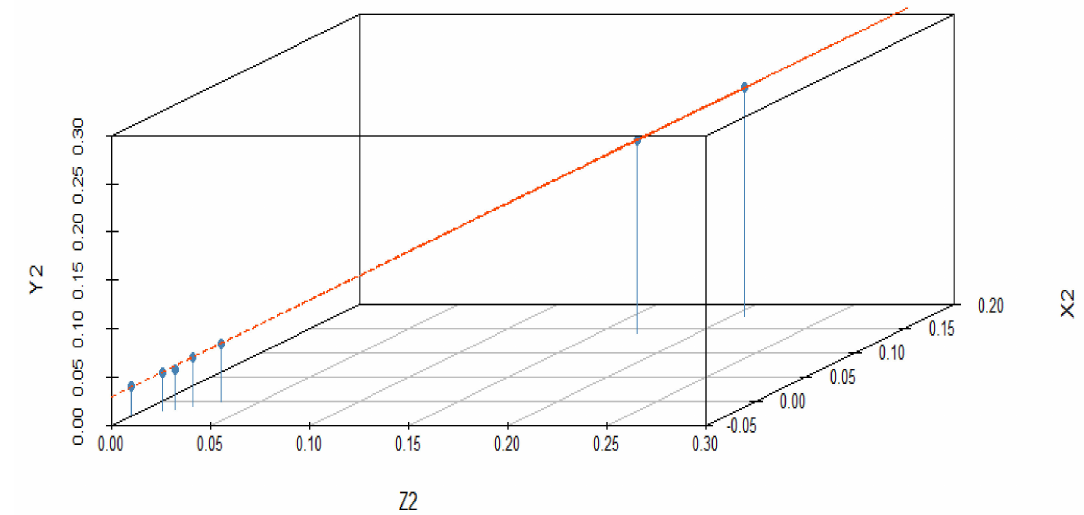
Figure 9. 3D illustration of correlation among the dependent and predictor variables for a difference of 0.03 from the experimentally fixed value at 420 ◦ C.